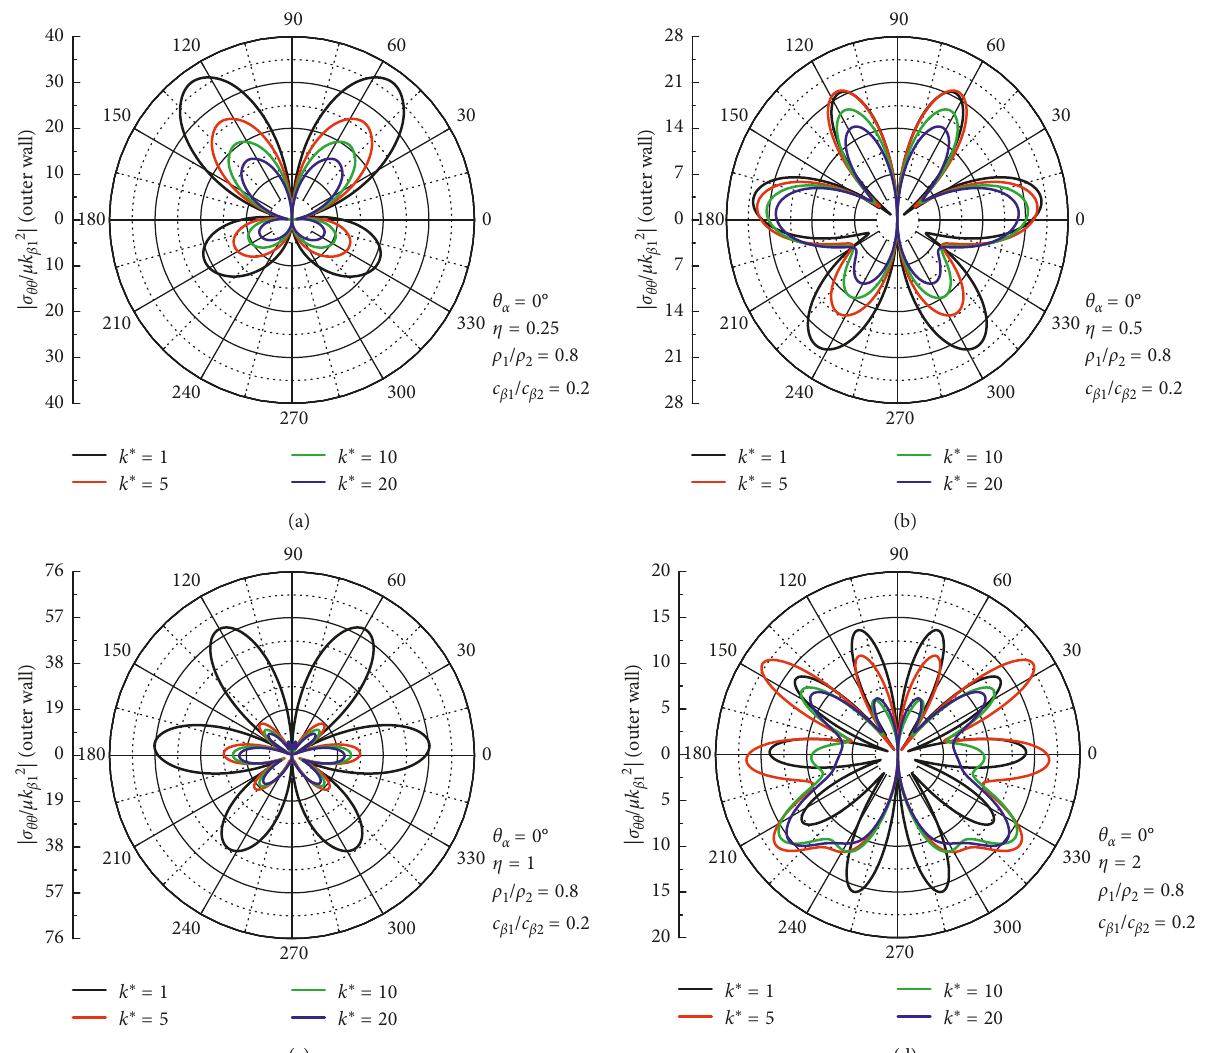
Figure 4: DSCF distribution on lining the outer wall under the incident SV wave ( θ